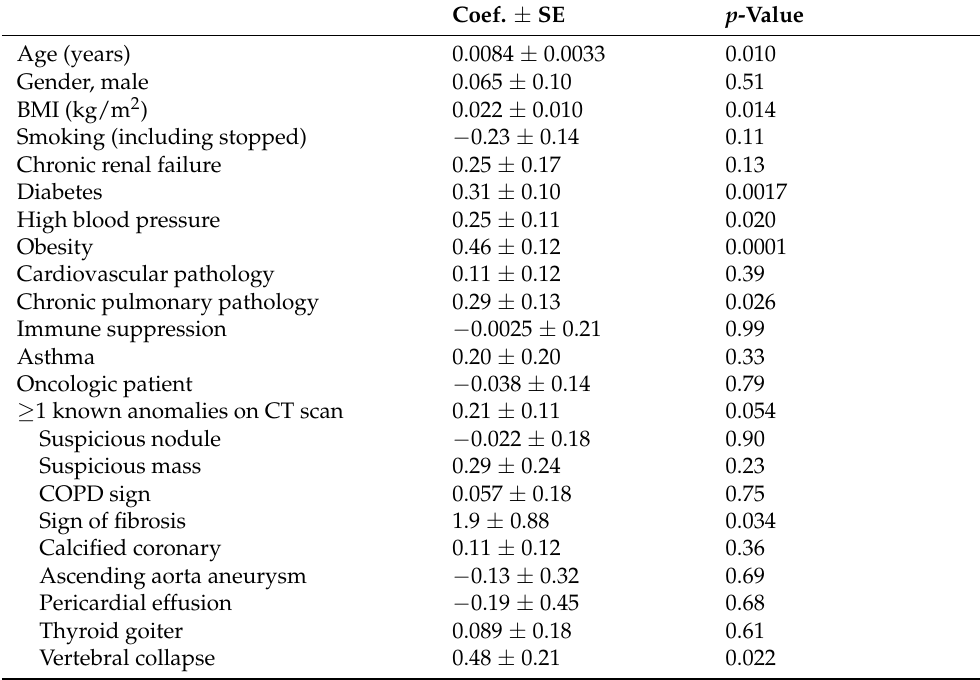
Table A4. Impact of patient’s characteristics on the length of stay (N = 330 COVID-19-hospitalized patients—linear regression on log-transformed length of stay adjusted for age and